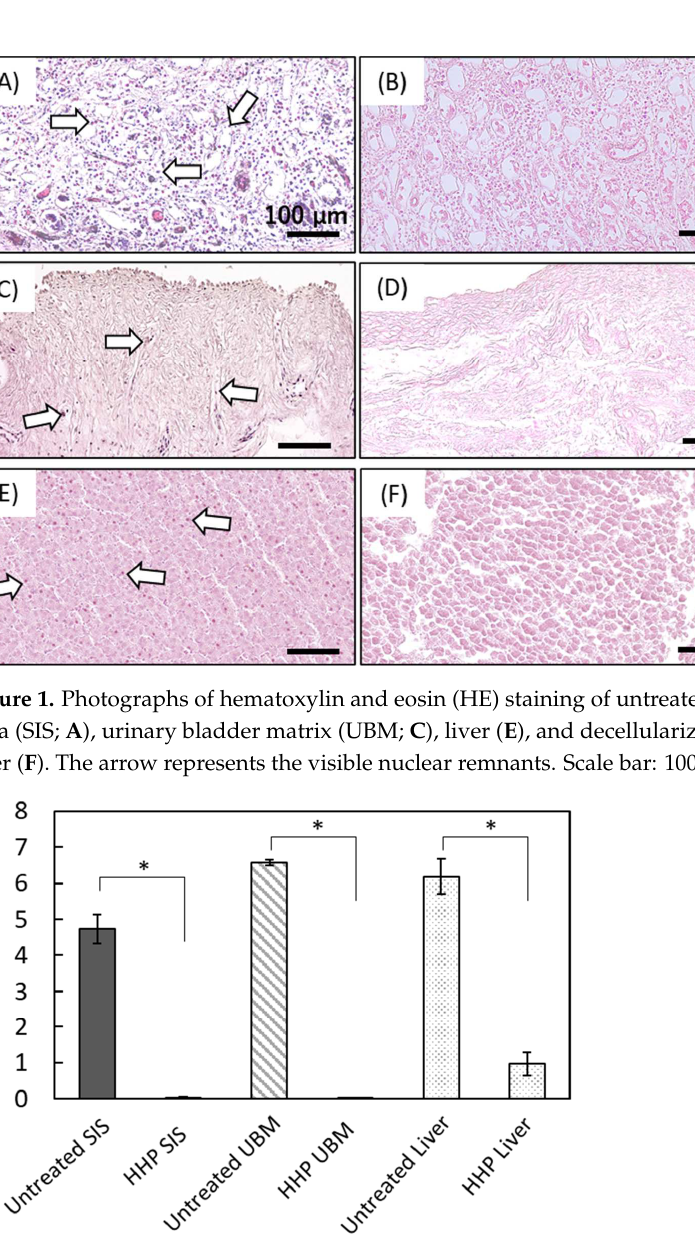
Figure 2. Quantitative analysis of residual double-stranded DNA (dsDNA) in decellularized tissues. * p < 0.01. HHP-decellularized tissues were lyophilized and milled into powder form. Pow- dered tissues dispersed in pepsin solutions were subjected to successive centrifugation and ultracentrifugation steps (Figure 3). The ultracentrifuged pellets derived from HHP- decellularized SIS, UBM, and liver were collected for further experiments.